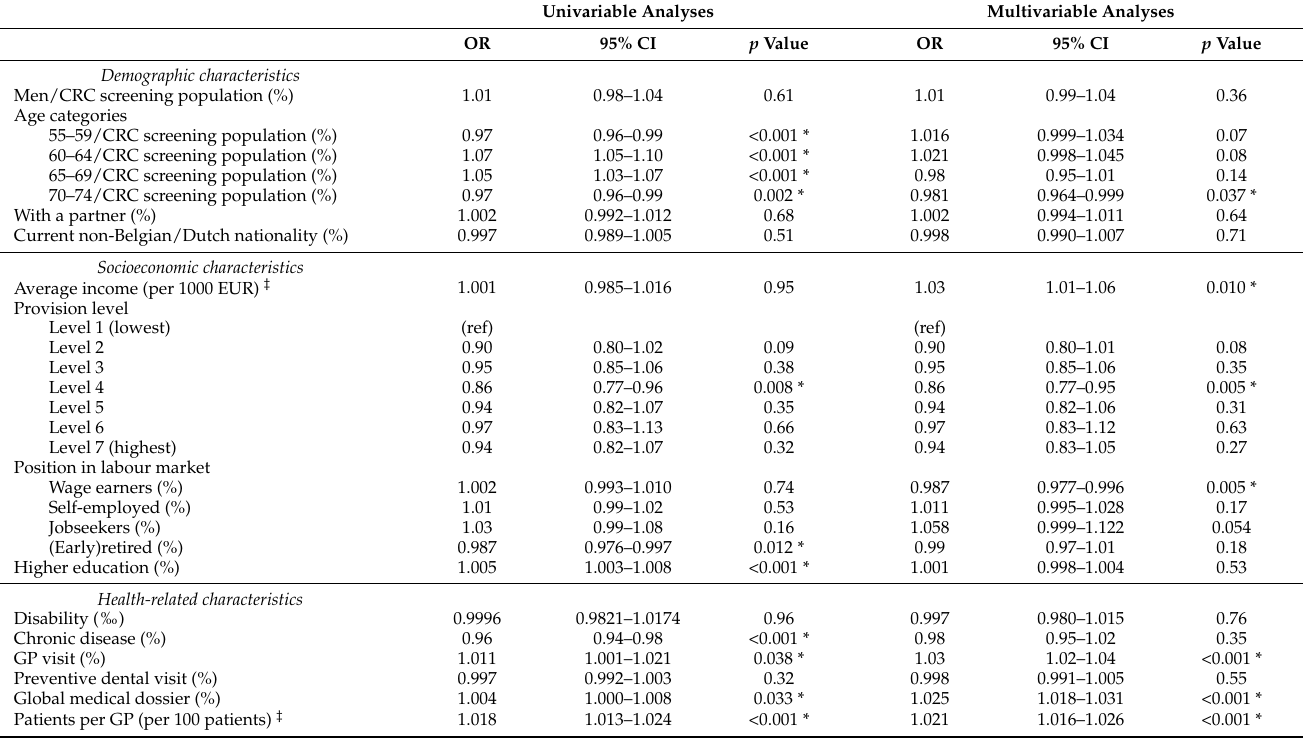
Table 4. Univariable and multivariable associations between municipal characteristics non-organised FOBT screening coverage. Univariable Analyses Multivariable